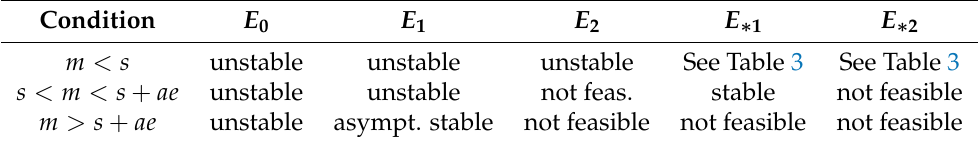
Table 2. Conditions for the feasibility and stability of the equilibria of the system in (23) and (24). Condition